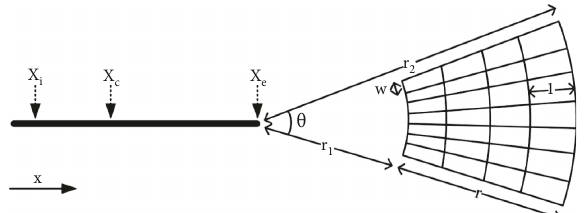
Figure 3: Schematic of the continuous approximation service area and